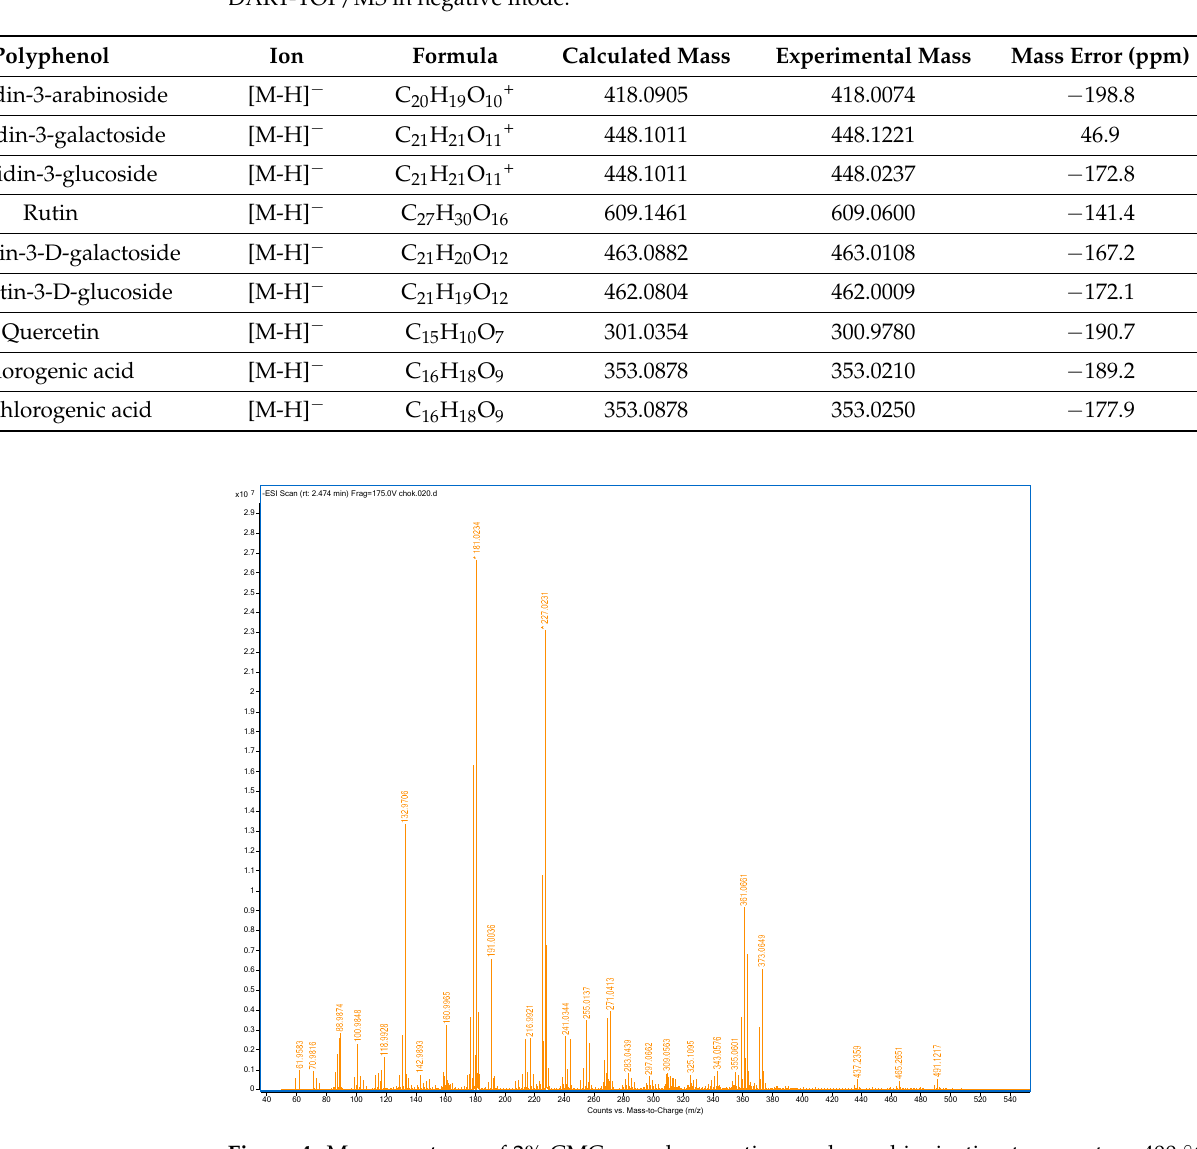
Figure 4. Mass spectrum of 2% CMC sample, negative mode, and ionization temperature 400 °C (CMC: carboxymethylcellulose).